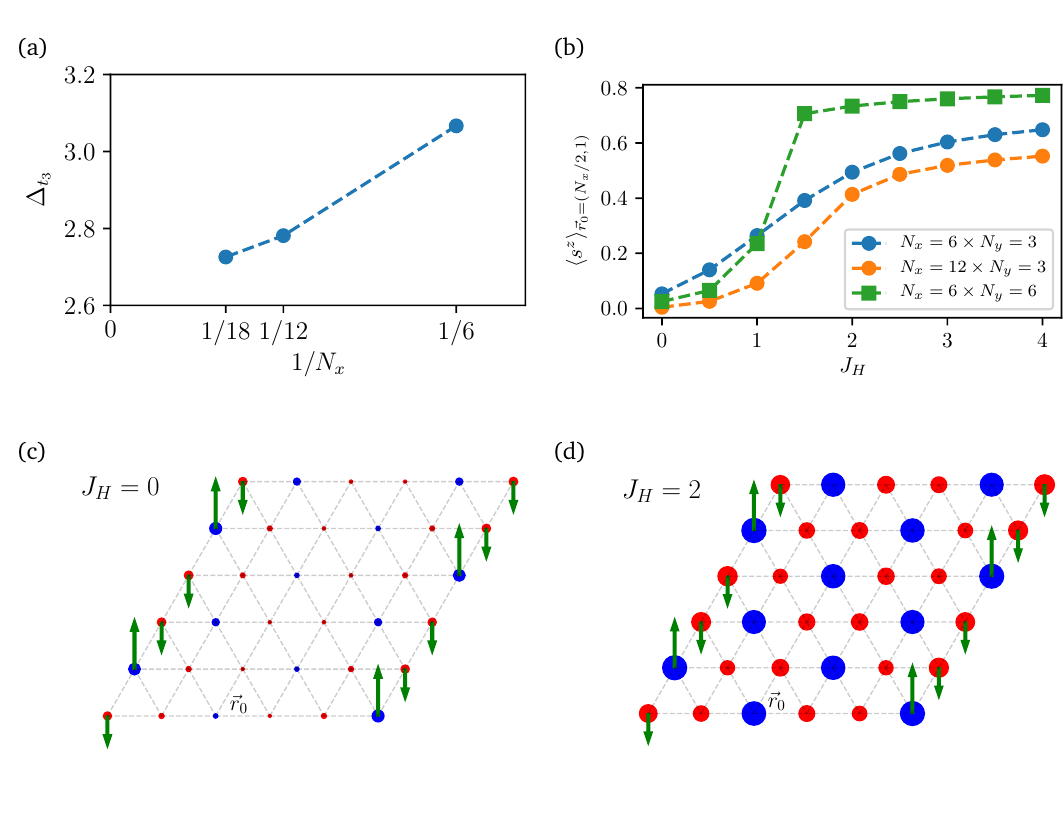
= 0, as function of inverse for J t 3 H = 3. (b) Magnetization on a site in y = ( x ) with x = N / 2, y = 1), as , y x 0 0 0 0 0 for different system sizes. Pinning fields are H = 0 and J = 2 respectively. The area of H H